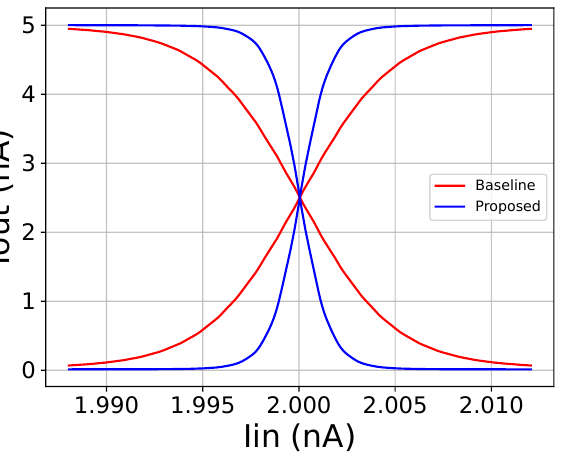
Figure 4. Left : A N neuron NMOS-based Lazzaro WTA circuit. Right : a modified NMOS-based Lazzaro WTA neuron. The PMOS-based variants for both circuits are built accordingly.